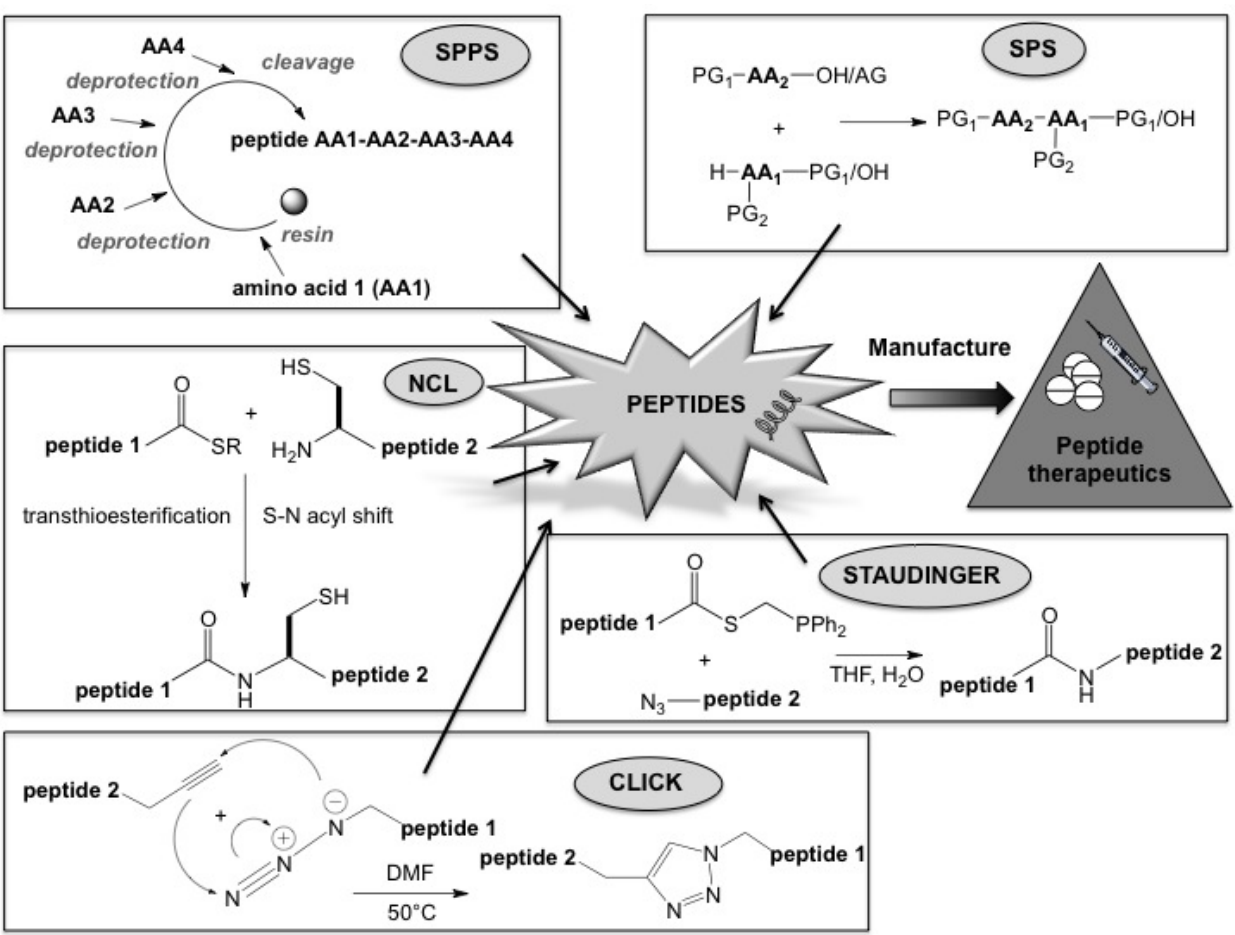
Scheme 1. Schematic representation of peptide